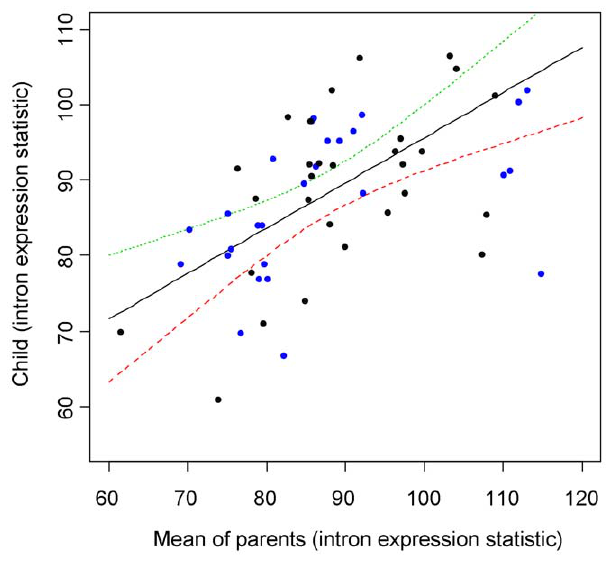
Figure 2. Heritability of the mean expression intensity of intronic probes. Points in the scatter plot of offspring values of the summary statistic against mean of the parent values are colored in blue for CEU trios and black for YRI trios. The estimated regression line (from the combined data) together with upper (green) and lower (red) bounds on the regression line estimates are shown.